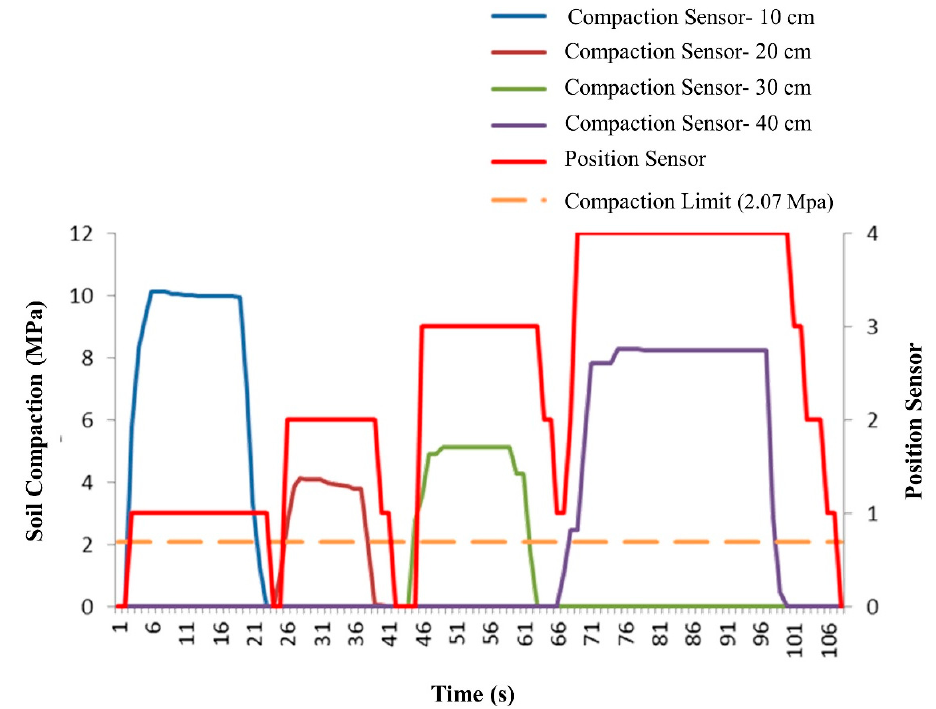
Figure 10. Combinational performance of compression sensors (depths of 10, 20, 30, and 40 cm), limit density (2.07 MPa), and the position of the subsoiler position sensor.